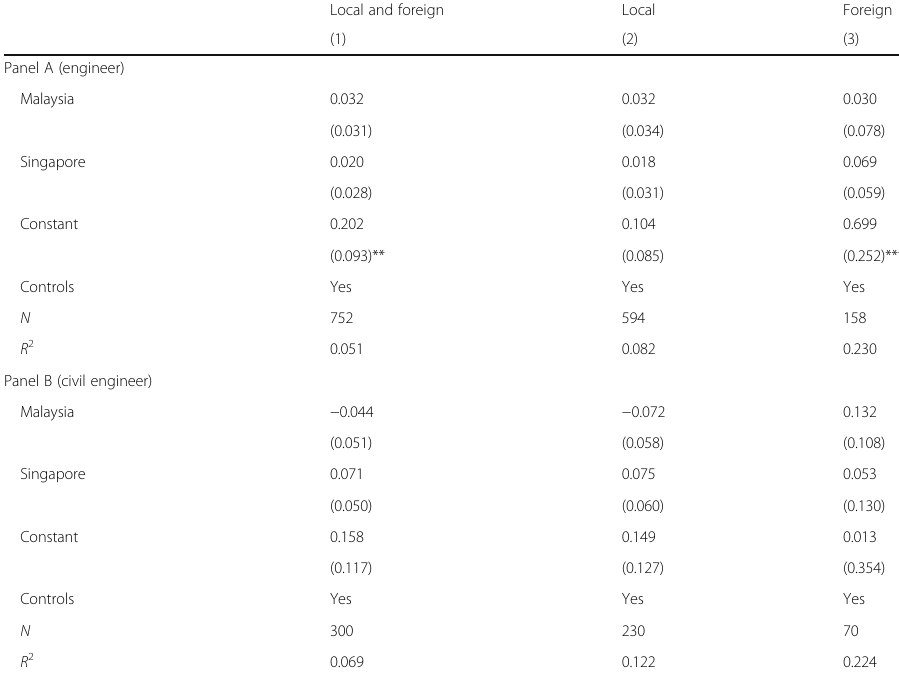
Table 12 Dependent variable: if a resume receives a callback for an interview (engineer)